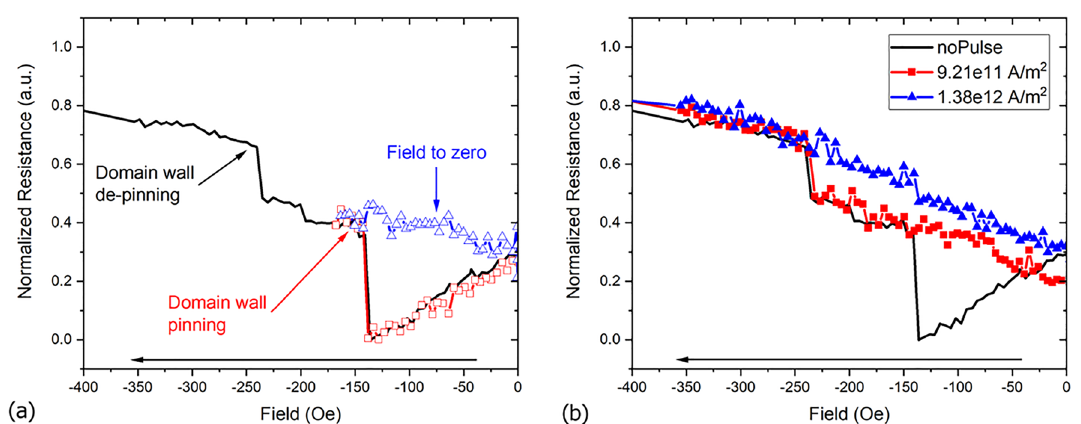
Figure 3. ( a ) Anisotropic magneto-resistance measurement of Ni/Co/Ni cylindrical nanowire with a pinned domain wall and the subsequent reduction of the external field to zero, after which nanosecond square current pulses were applied. ( b ) Magnetoresistance profile after two different current pulses were applied at zero field: 9.21 × 10 11 A/m 2 , 10 ns width (red squares), the de-pinning resistance jump indicates the domain wall was not de-pinned; 1.38 × 10 12 A/m 2 , 20 ns (blue triangles) results in the de-pinning of the DW as the depinning resistance jump is not